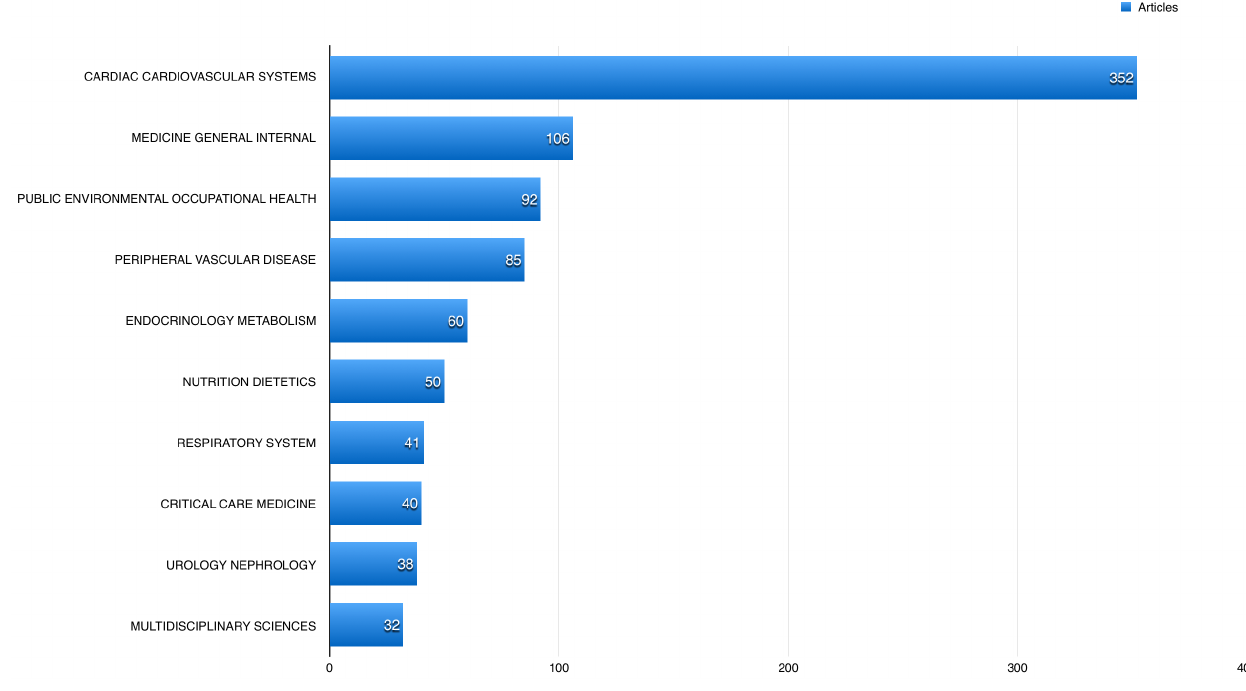
Figure 4. The 10 most common fields the studied open data articles published in.